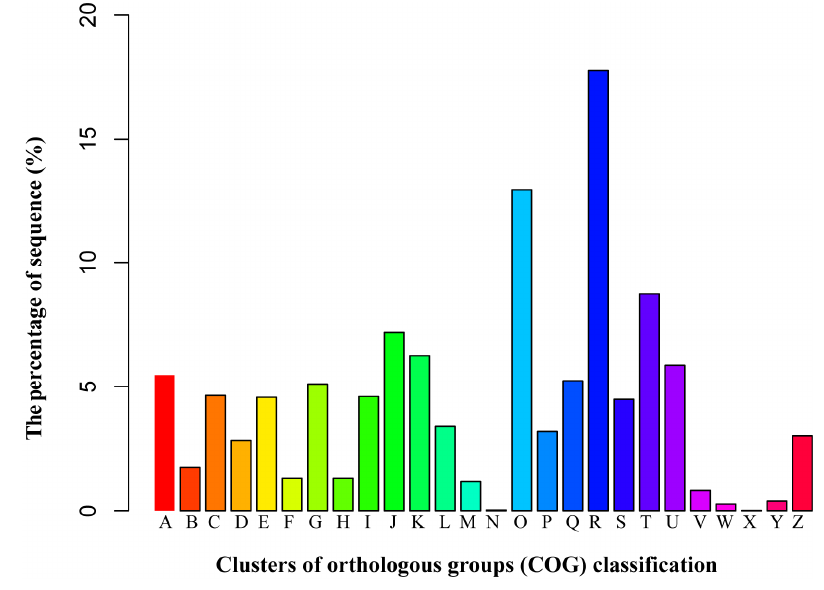
Figure 3. Histogram presentation of clusters of orthologous groups (COG) classification. All unigenes were aligned to COG database to predict and classify possible functions. Out of 27,435 Nr hits, 11,983 sequences were assigned to 26 COG classifications. (A) RNA processing and modification; (B) chromatin structure and dynamics; (C) energy production and conversion; (D) cell cycle control, cell division, chromosome partitioning; (E) amino acid transport and metabolism; (F) nucleotide transport and metabolism; (G) carbohydrate transport and metabolism; (H) coenzyme transport and metabolism; (I) lipid transport and metabolism; (J) transition, ribosomal structure and